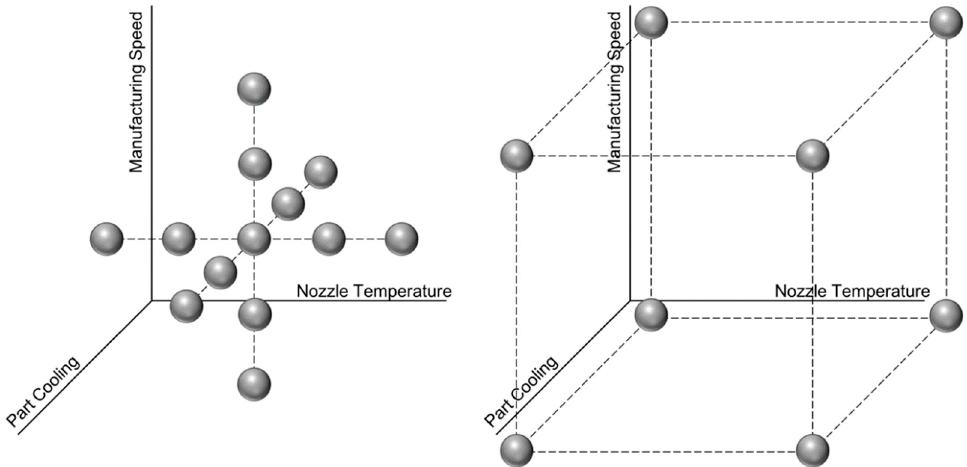
Figure 3. Design of experiments for creating training data. For better illustration, corner points are separated from the star pattern. Combined, the two graphs represent the entire trial plan.